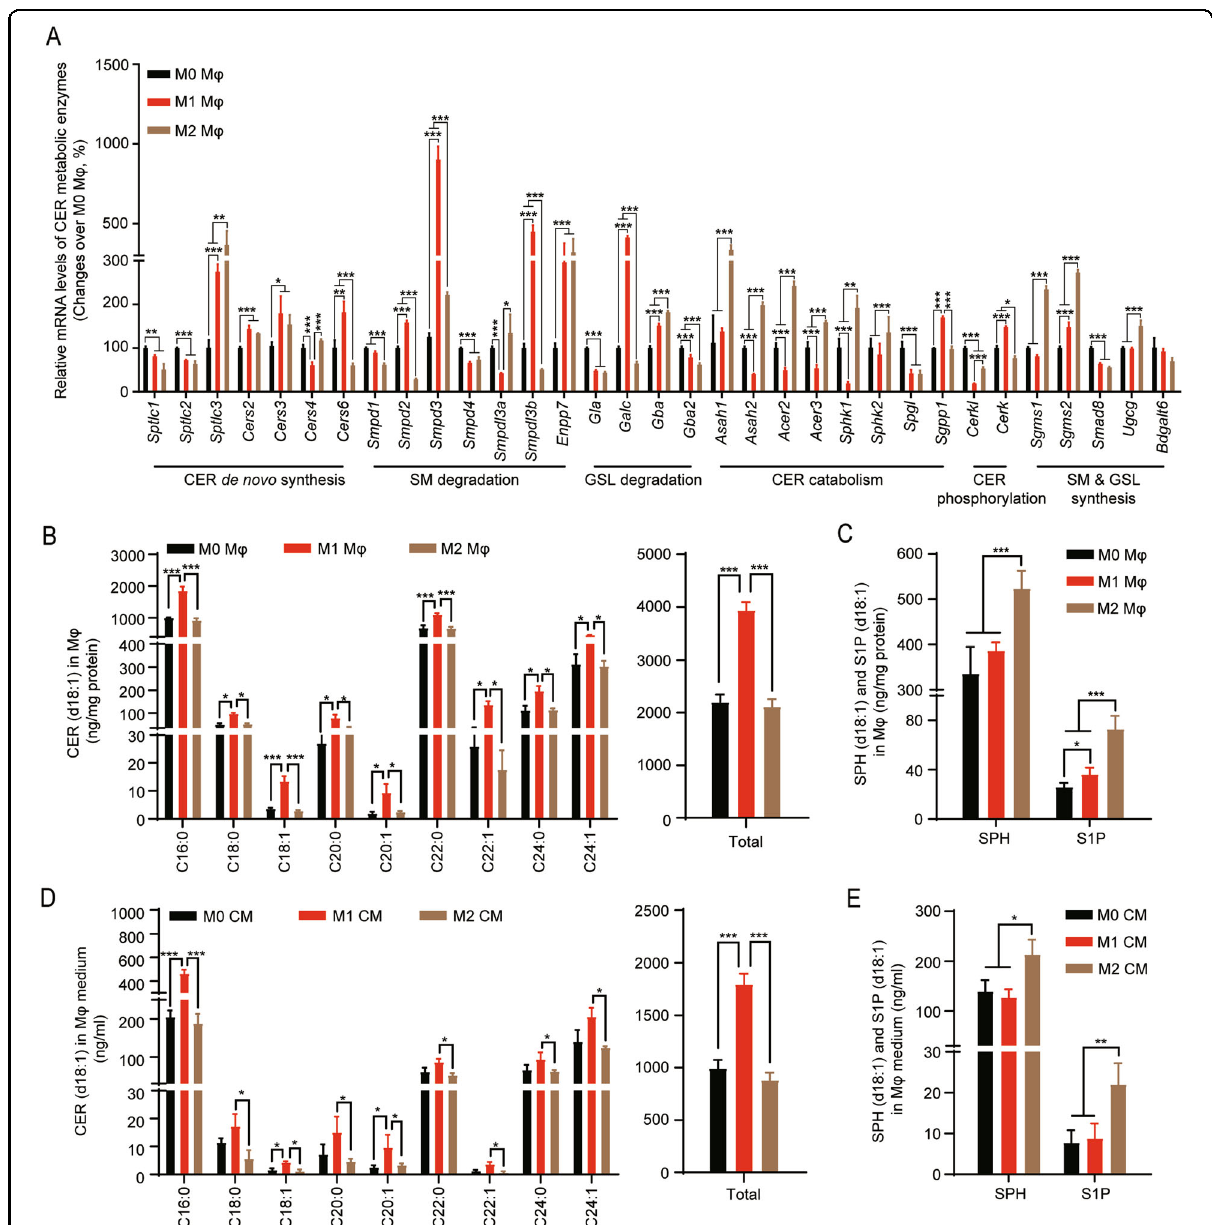
Fig. 2 Polarized BMDMs express distinct CER metabolic pathway. A Total RNA of M0, M1, and M2 BMDMs was extracted to examine the mRNA levels of CER metabolic enzymes by qPCR. B – E Polarized BMDMs ( B and C ) and their CM ( D and E ) were collected to measure the levels of CER metabolites by targeted UHPLC-ESI-MS/MS, including d18:1-CER, d18:1-SPH, and d18:1-S1P. Data represent results from three independent experiments and demonstrated as mean ± SD; * p < 0.05, ** p < 0.01, *** p <